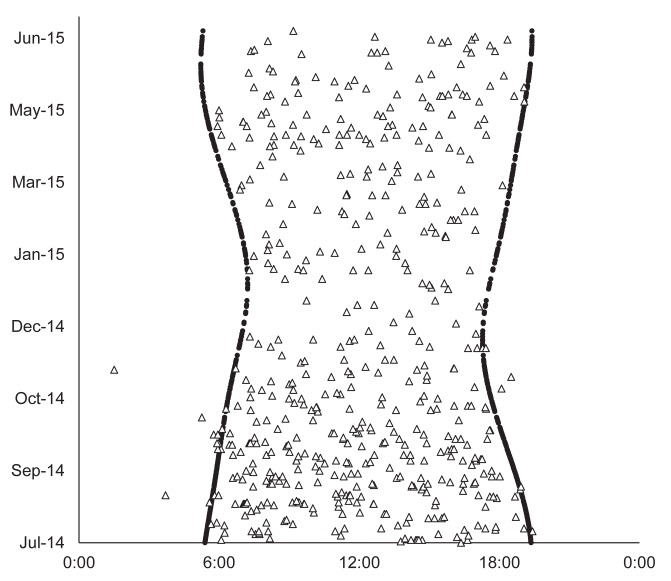
Dates and times when the videos of Japanese macaques were taken (triangle).Circles indicate the time of sunrise and sunset.